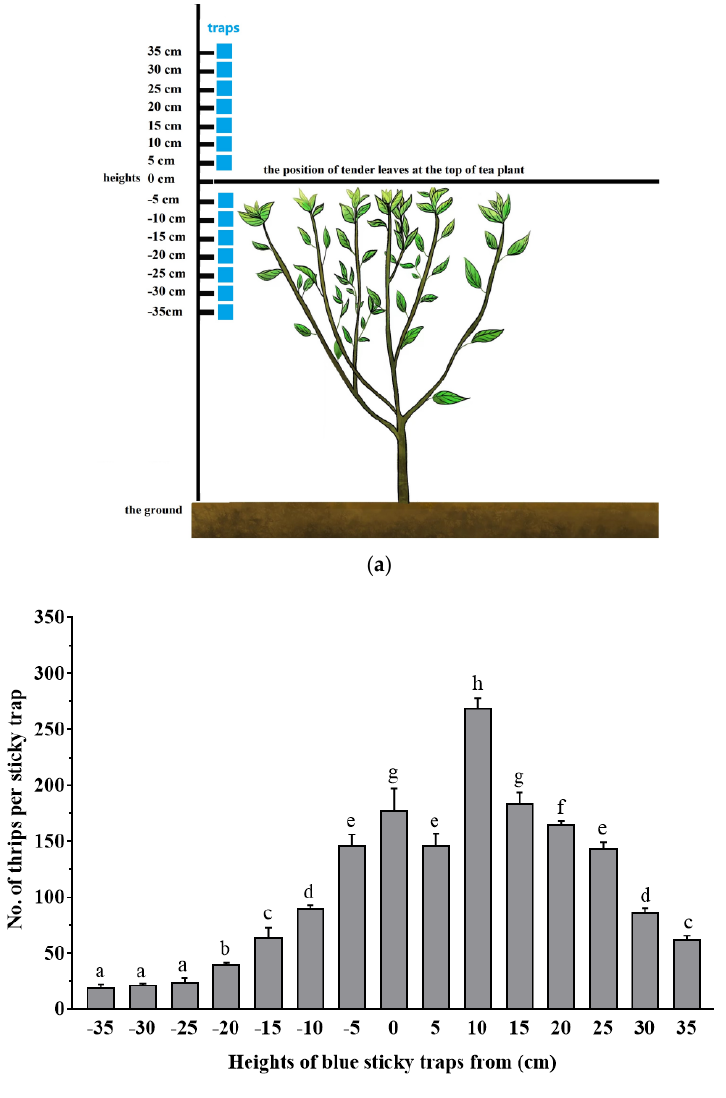
Figure 2. Schematic diagram of how the traps were placed at different heights from below (negative numbers) to above (positive numbers) the position of tender leaves at the top of the tea plant in tea plantations ( a ) and the numbers (mean ± SEM) of D. minowai adults captured in traps ( b ). Different lowercase letter denotes a difference at the p < 0.05 level, while the same lowercase letter was not significantly different ( p > 0.05) (ANOVA followed by